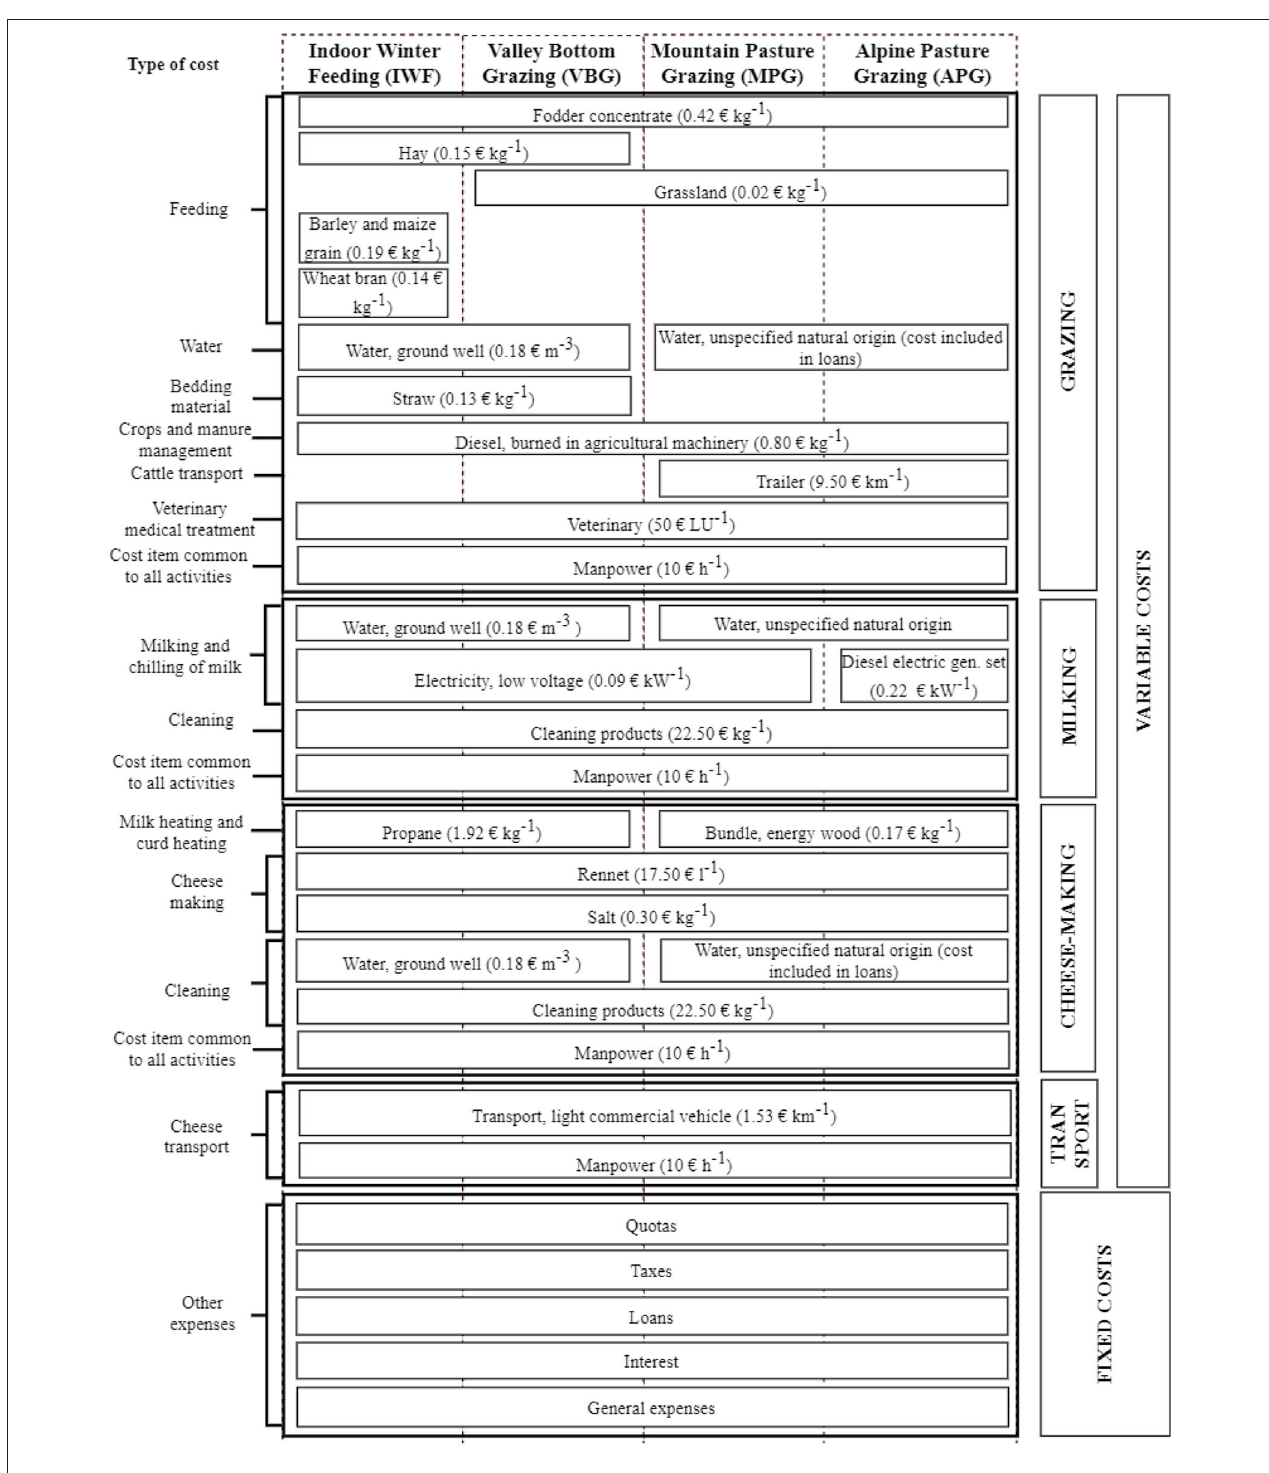
FIGURE 2 | Cost items and price of inputs. remunerated at opportunity cost considering an interest rate of 1.0% for land use, 3.0% for capital goods, in agreement with Blanc et al. (57). The overheads item includes labor